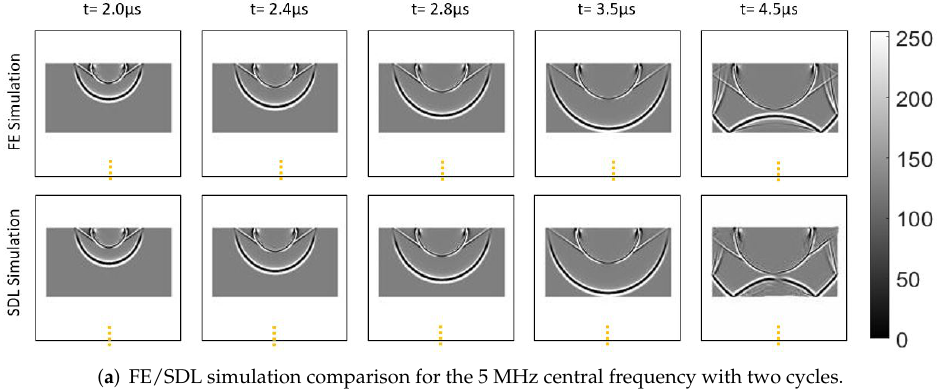
Figure 9. Line scans of reflected wave propagation with varying frequency: The FE- and SDL-model- generated simulations are compared, quantitatively, by extracting the displacement values, which are extracted at x = 15 mm and y = 0 to 40 mm for different time instances, from Figure 8. ( a ) Represents the line scans that are extracted from Figure 8a for 4 MHz, and ( b ) illustrates the line scans that are extracted from Figure 8b, for 7 MHz in the rectangular domain.